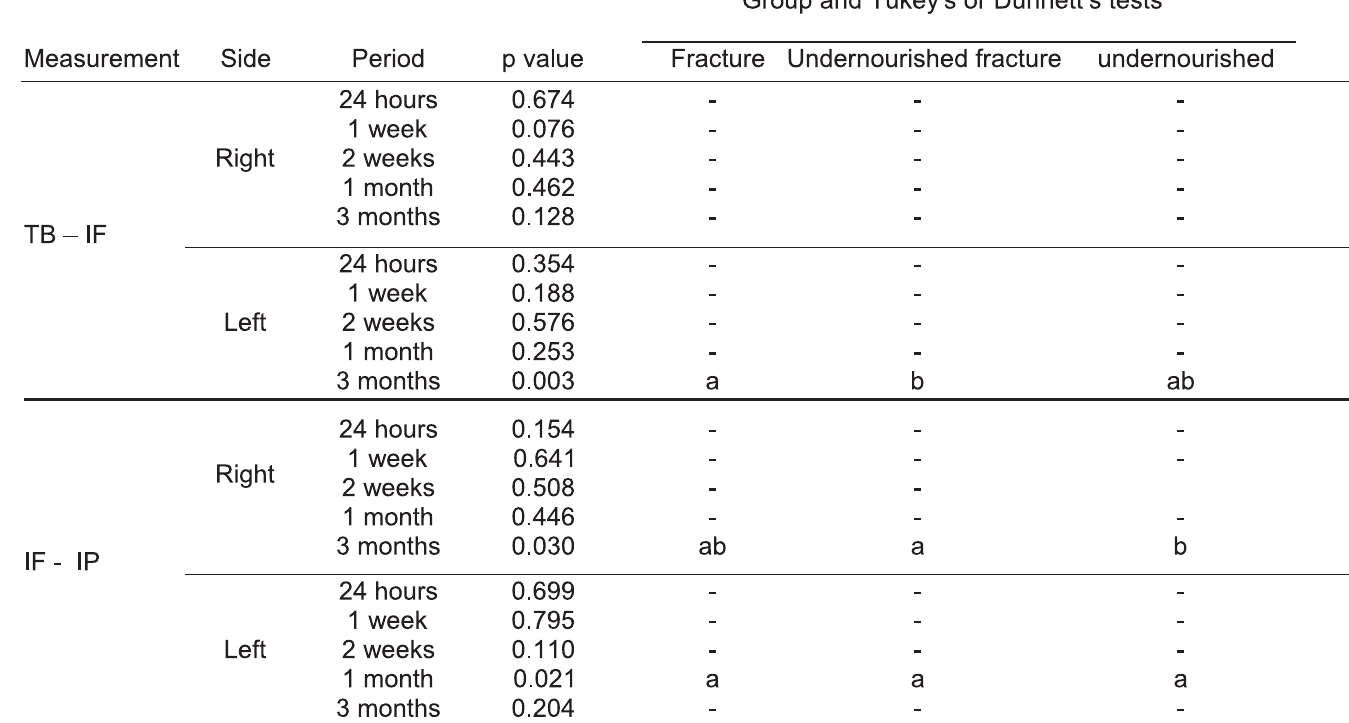
Distinct letters indicate statistically significant difference